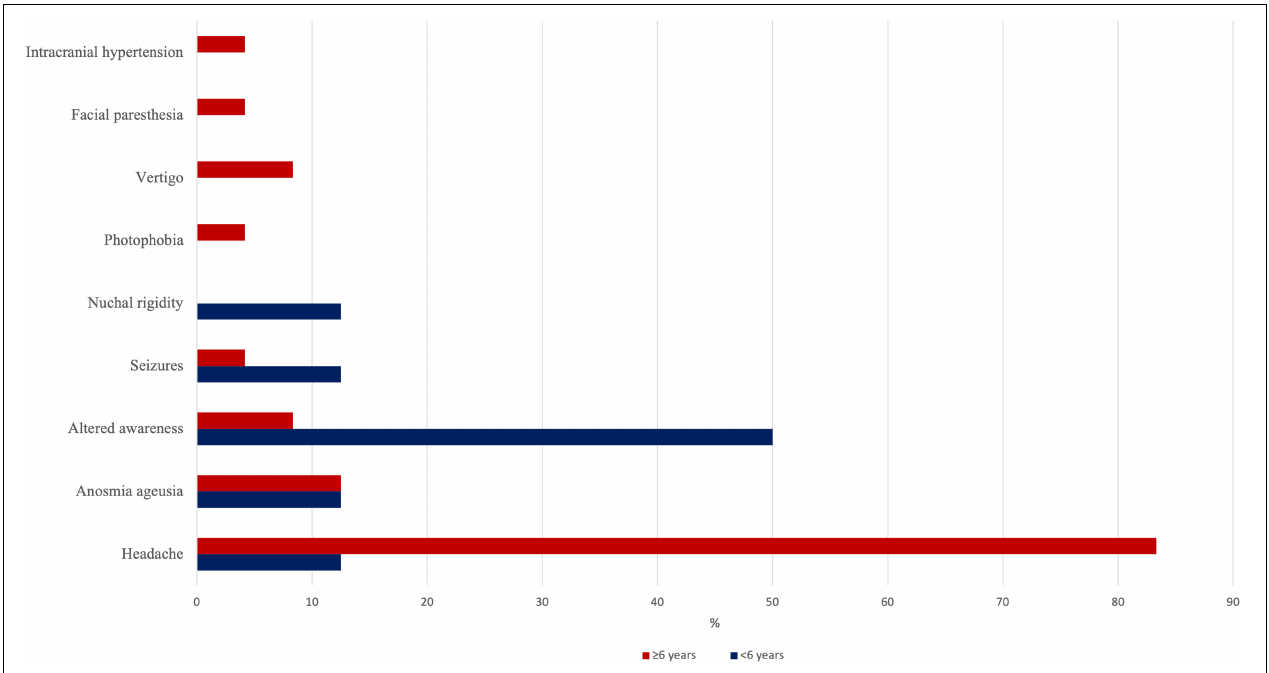
FIGURE 1 | Prevalence of each neurological manifestation in our series, stratified by age subgroups ( < 6 or > 6